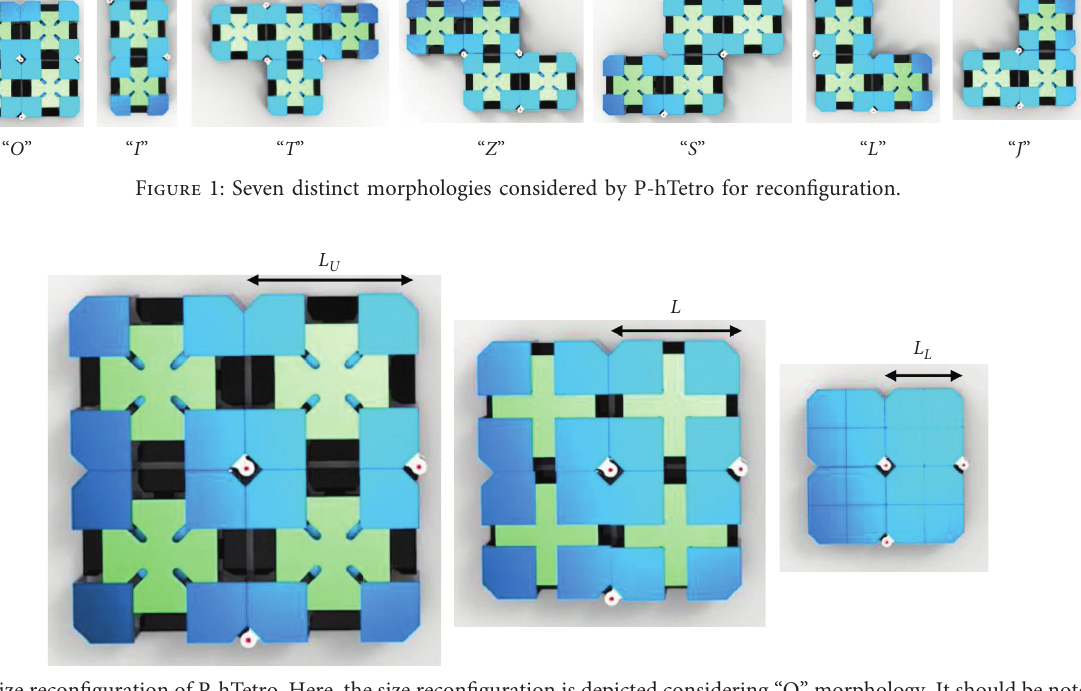
Figure 2: Size reconfiguration of P-hTetro. Here, the size reconfiguration is depicted considering “O” morphology. It should be noted that the size can be reconfigured in any morphology.